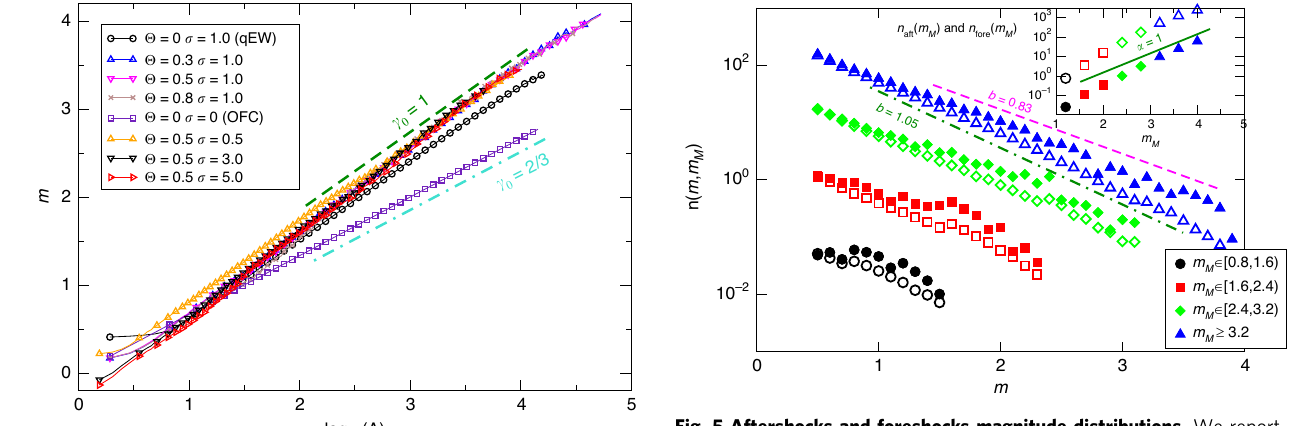
Fig. 5 Aftershocks and foreshocks magnitude distributions. We report the total number of aftershocks n aft ( m , m M ) (open symbols) and foreshocks Fig. 4 The m – log A scaling. We plot the magnitude m versus log ( A ), for n fore ( m , m M ) ( fi lled symbols), with magnitude m , grouped by their Θ = 0.5, σ = 5, L = 1000 and ϵ = 0.008. Lines correspond to the relation mainshock's magnitude m M (see legend). We always consider Θ = 0.5, ð A Þ with γ = 1 (green dashed) and γ = 2/3 (turquoise dot- σ = 5, L = 1000, and ϵ = 0.008. Lines correspond to the GR law with b = m ¼ γ 0 0 0 log 10 dashed). 1.05 (green dot-dashed) and b = 0.83 (magenta dashed). (Inset) The aftershock number n aft ( m M ) (empty symbols) and the foreshock number n fore ( m M ) ( fi lled symbols) versus m M . The green line is the productivity law with α =